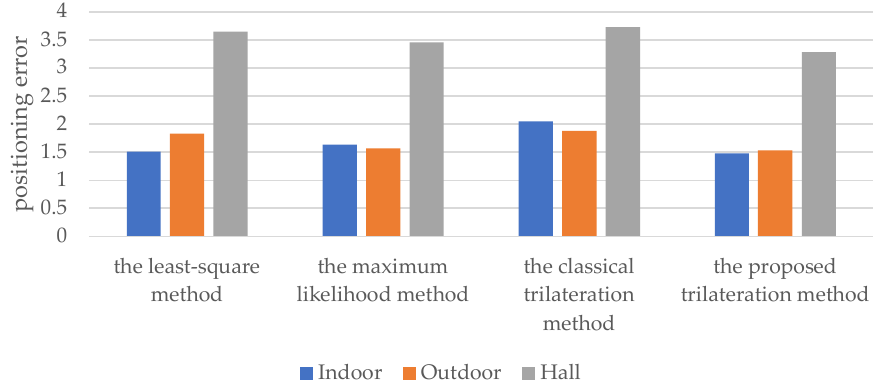
Figure 14. The positioning error of the four methods in different environments.